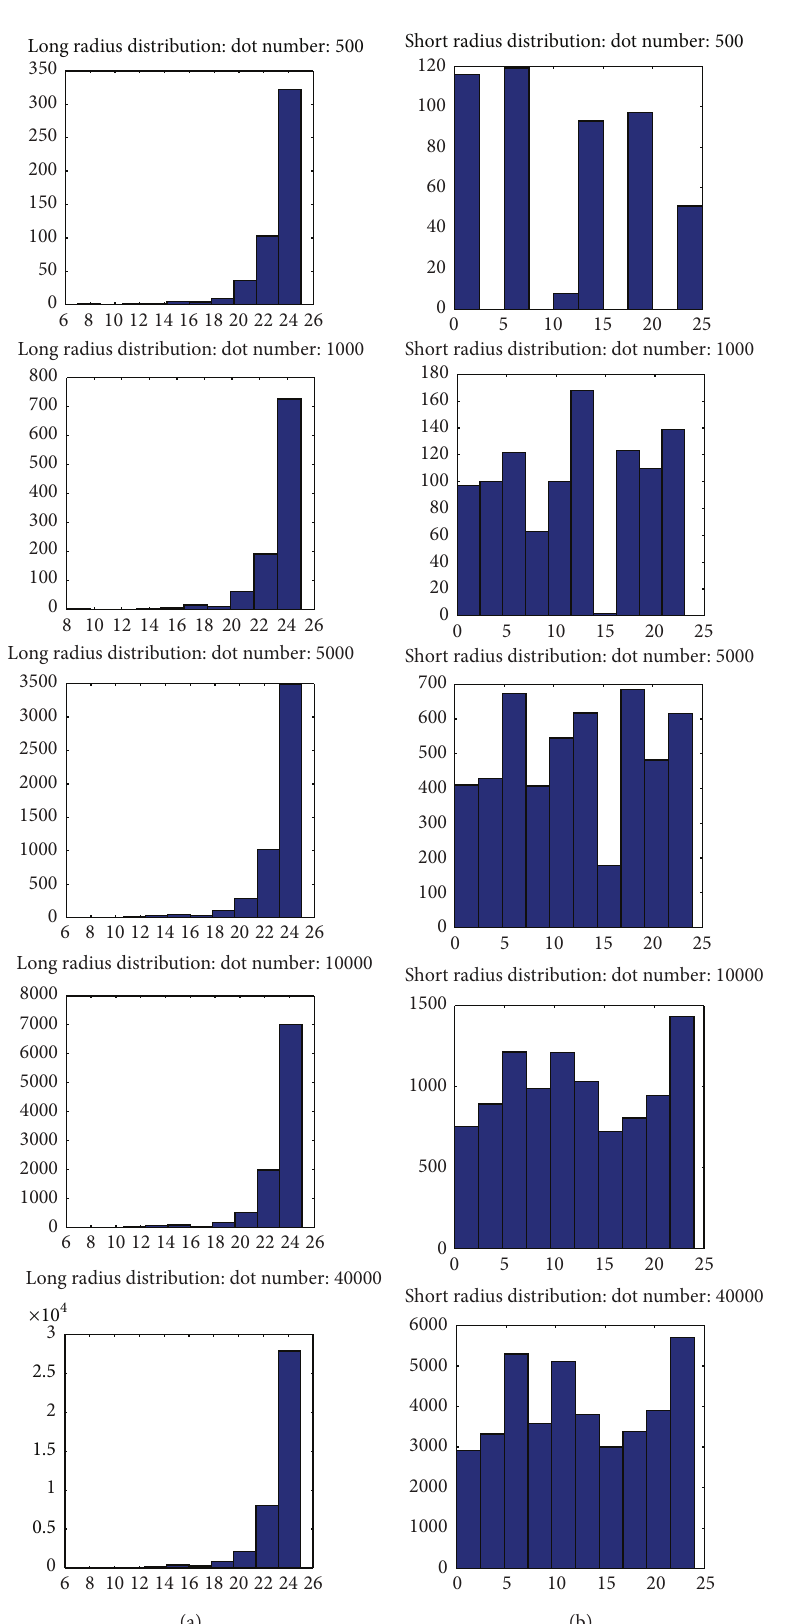
Figure 10: Dot radius distributions (left column: long radius; right column: short radius) from 500, 1000, 5000, and 10000 to 40000 dots in Figure